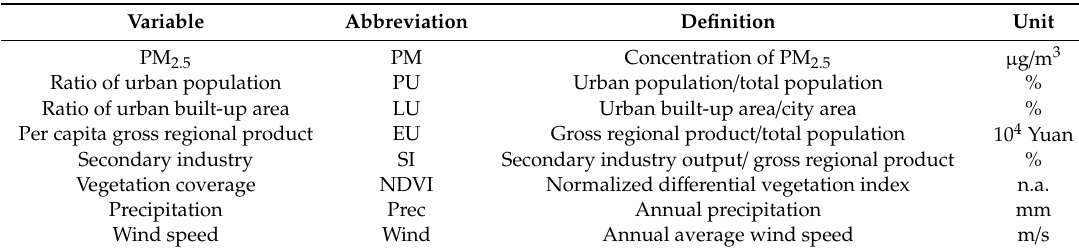
Table 1. Description of the